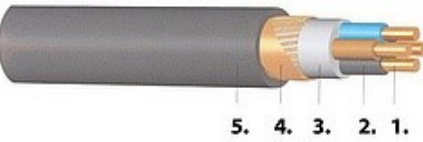
Figure 1. The construction of the cable: four copper conductors ( 1 ), PVC core insulations ( 2 ), filling material ( 3 ), copper wire and tape screens ( 4 ), and PVC jacket ( 5 ).